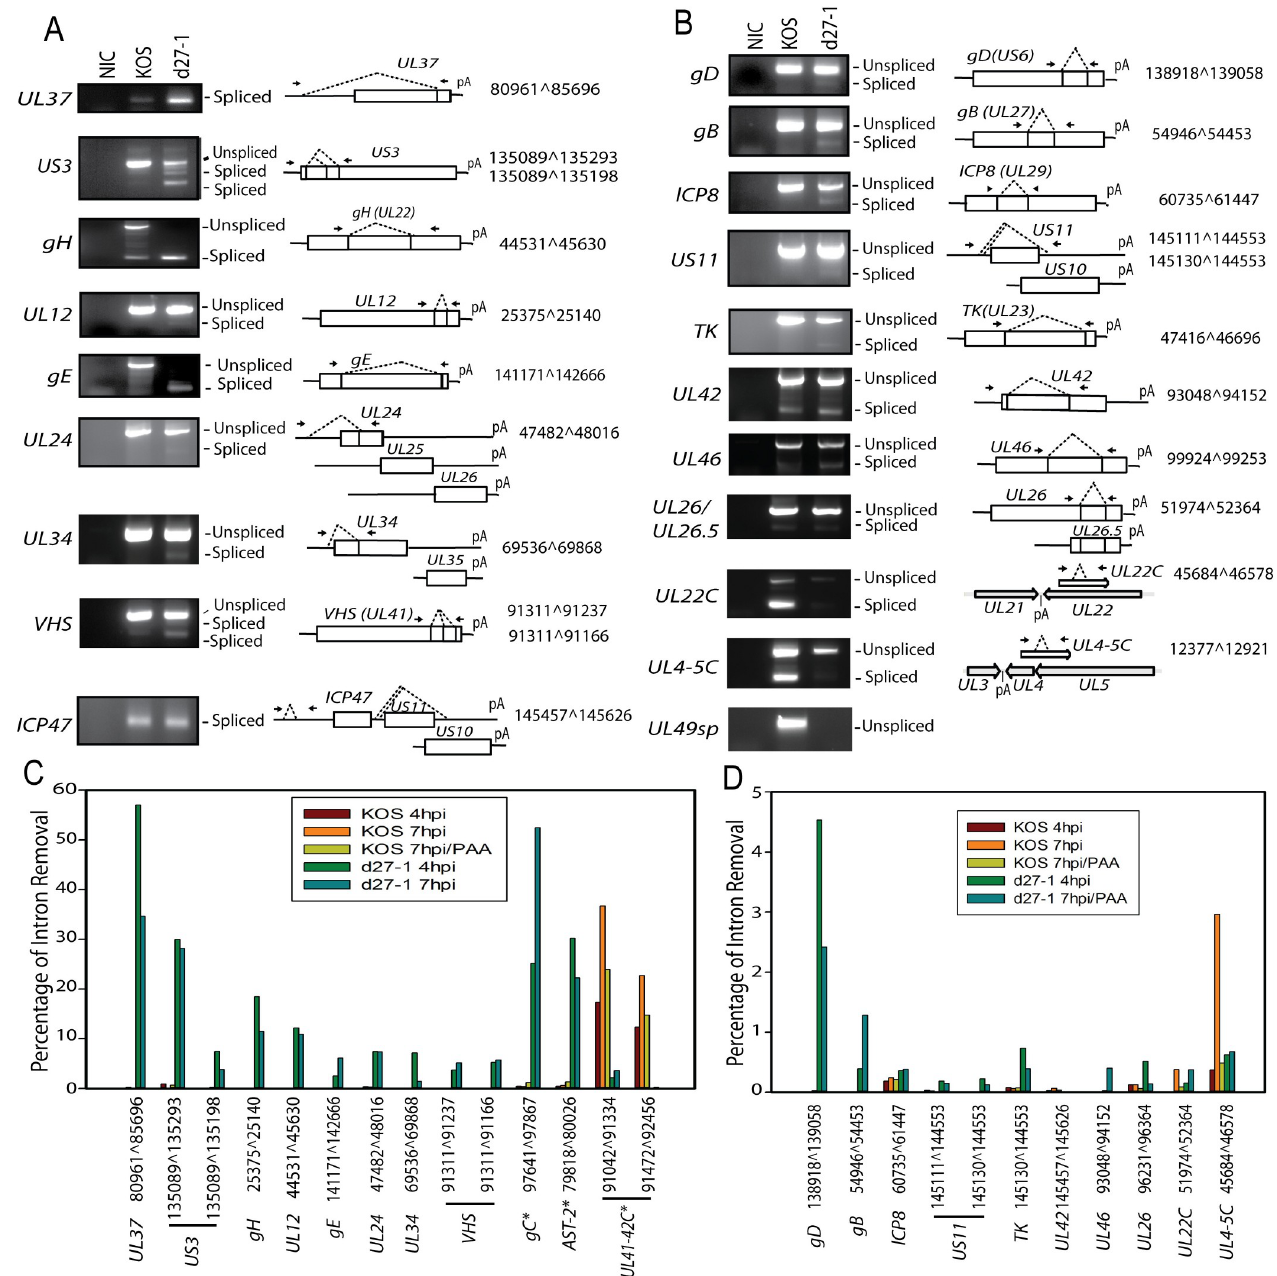
Fig 8. Pre-mRNA splicing of most of the identified novel spliced genes is inhibited by ICP27. The novel spliced isoforms listed in Table 1 and not discussed in other figures were verified by RT-PCR using total RNAs from KOS and d27-1 infected HEK-293 cells prepared at 7 hpi. Corresponding PCR bands were topo-cloned and verified by DNA sequencing. The RT-PCR results were grouped in Panel ( A ) for transcripts with splicing efficiency � 5% or Panel ( B ) for transcripts with splicing efficiency < 5%. The RT-PCR for ICP47 and UL49sp was used as a control. The diagrams on the right illustrate the relative location of the primers and the verified splices. Splicing efficiency of splice variants (confirmed in this study but not shown in other figures) was determined using the RNA-Seq data obtained from infected HEK-293 cells and is summarized in ( C ) for transcripts with relative splicing efficiency � 5% or ( D ) for transcripts with relative splicing efficiency < 5%. � Relative splicing efficiency of previously identified non-IE spliced genes including gC , AST-2 and UL41-42C was also included in the analysis.